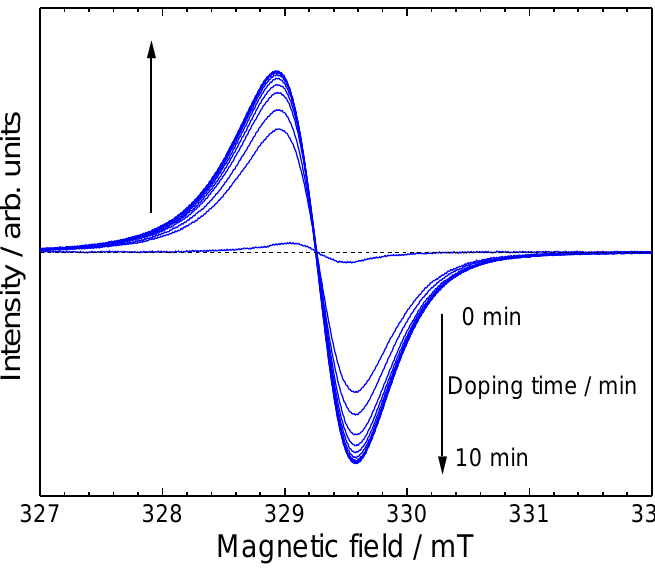
Figure 7. In-situ ESR spectra during vapor phase iodine doping.